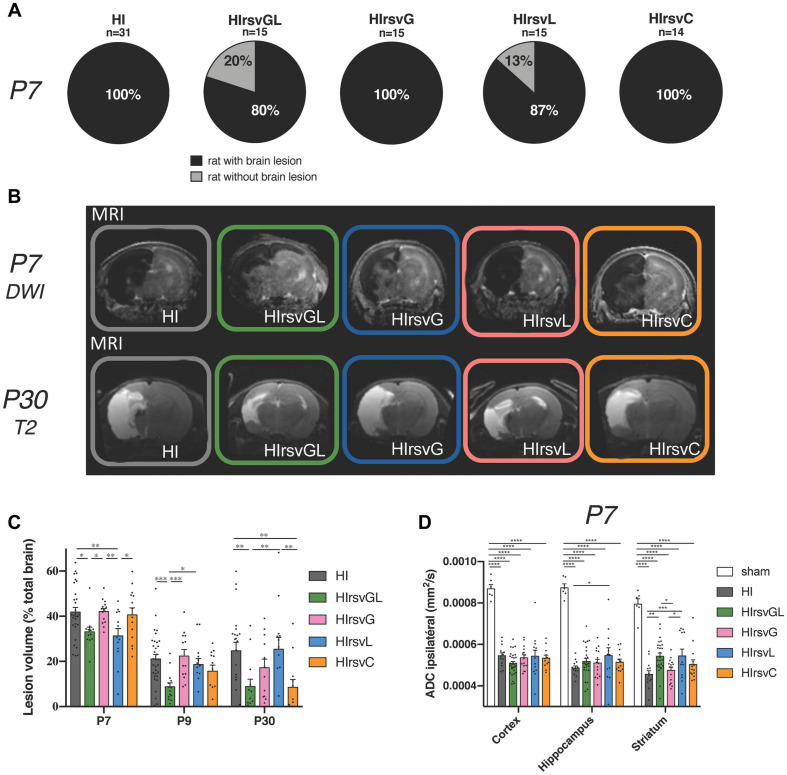
Visualization and quantification of brain lesion volume with or without resveratrol treatment after a hypoxic-ischemic event. (A) Percentage of P7 pups with brain lesion for HI, HIrsvGL, HIrsvG, HIrsvL, and HIrsvC groups, 3 h after injury. Pups with brain lesion volume <1% of the total brain volume were considered without brain lesion. (B) ADC maps obtained after DWI at P7 (top) and T2-weighted images at P30 (bottom) of pup brains for HI, HIrsvGL, HIrsvG, HIrsvL, and HIrsvC groups, acquired on a 4.7 T magnet. DWI was systematically performed 3 h after the common carotid artery ligation. Damage appeared as a hyposignal at P7 (decrease in ADC values due to the edema and cell swelling) and as a hypersignal at P30 (necrotic zone, water and cell death). (C) Lesion volumes (% total brain volume) at P7 (3 h after the common carotid artery ligation; n = 31, n = 12, n = 15, n = 13, and n = 15 for HI, HIrsvGL, HIrsvG, HIrsvL, and HIrsvC groups, respectively), at P9 (48 h after the hypoxic-ischemic event; n = 25, n = 14, n = 13, n = 14, and n = 12 for HI, HIrsvGL, HIrsvG, HIrsvL, and HIrsvC groups, respectively), and P30 (23 days after the hypoxic-ischemic event; n = 22, n = 13, n = 12, n = 13, and n = 12 for HI, HIrsvGL, HIrsvG, HIrsvL, and HIrsvC groups, respectively). (D) ADC values (mm2/s) in cortical, hippocampal and striatal lesions at P7. Results are mean values ± SEM. (C,D): one-way analysis of variance (ANOVA) with Fisher’s LSD post hoc test. ∗: Significant difference between two groups (∗: p < 0.05, ∗∗: p < 0.01, ∗∗∗: p < 0.001, and ****: p < 0.0001).